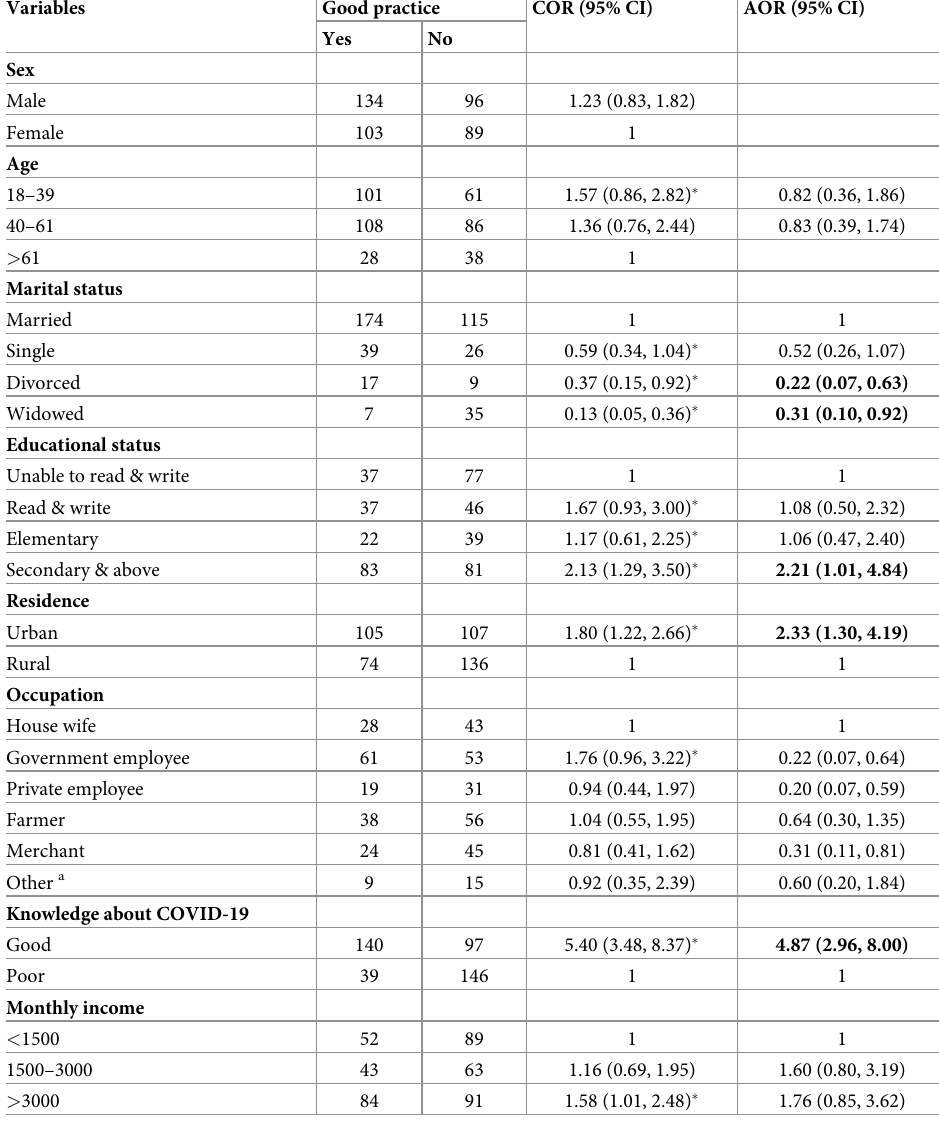
Table 5. Factors associated with good practice of COVID-19 prevention methods among chronic disease patients, at selected public hospitals of Sidama regional state, Ethiopia, 2020 (N =